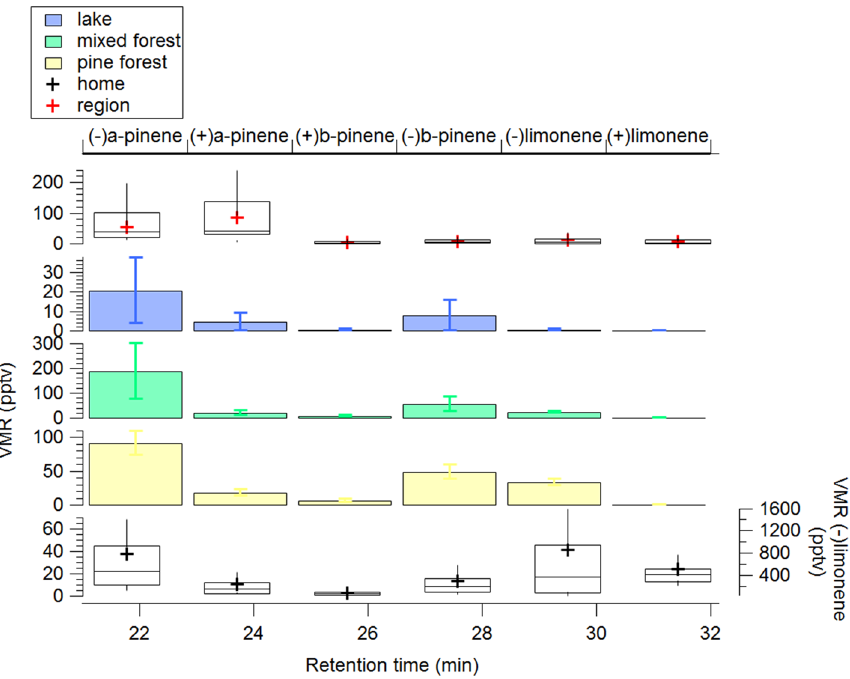
Figure 3. Volume mixing ratio (VMR) distribution of enantiomers from three ecosystems surrounding the birds’ aviary and at the birds’ aviary. Category plots show mean measured values with their standard deviation from three days of sampling during summer 2017. Box plots show mean campaign values (marker), median (line), interquartile range (box) and 10th and 90th percentiles (whiskers) from 2 months intensive field campaign at the birds’ aviary in spring 2018 (home) and from three flights conducted at 180 m altitude over the region during the airborne campaign. The x axes shows the retention time (min) of the chiral molecules in the gas chromatography mass spectrometer (GC–MS) and shows the good resolution achieved with the method. The left y axes indicate the volume mixing ratio of all molecules, except for (−)limonene measured at the aviary, whose VMR is indicated by the right y